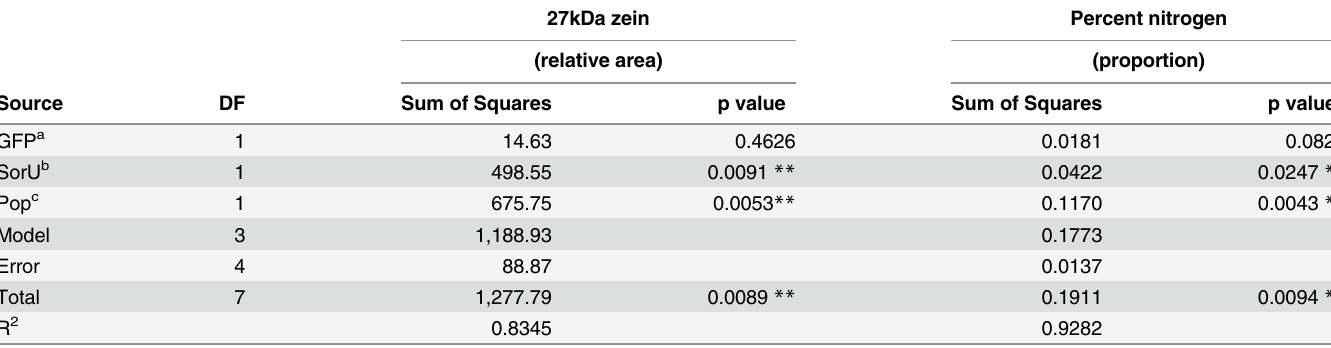
Table 2. Analysis of variance of 27kDa gamma zein peak area and percent nitrogen.